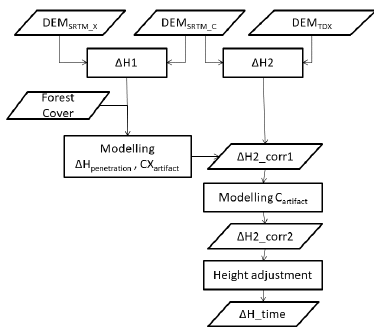
Figure 1. Flowchart for estimating temporal change in X-band InSAR elevation in Uganda ( Δ H_time).